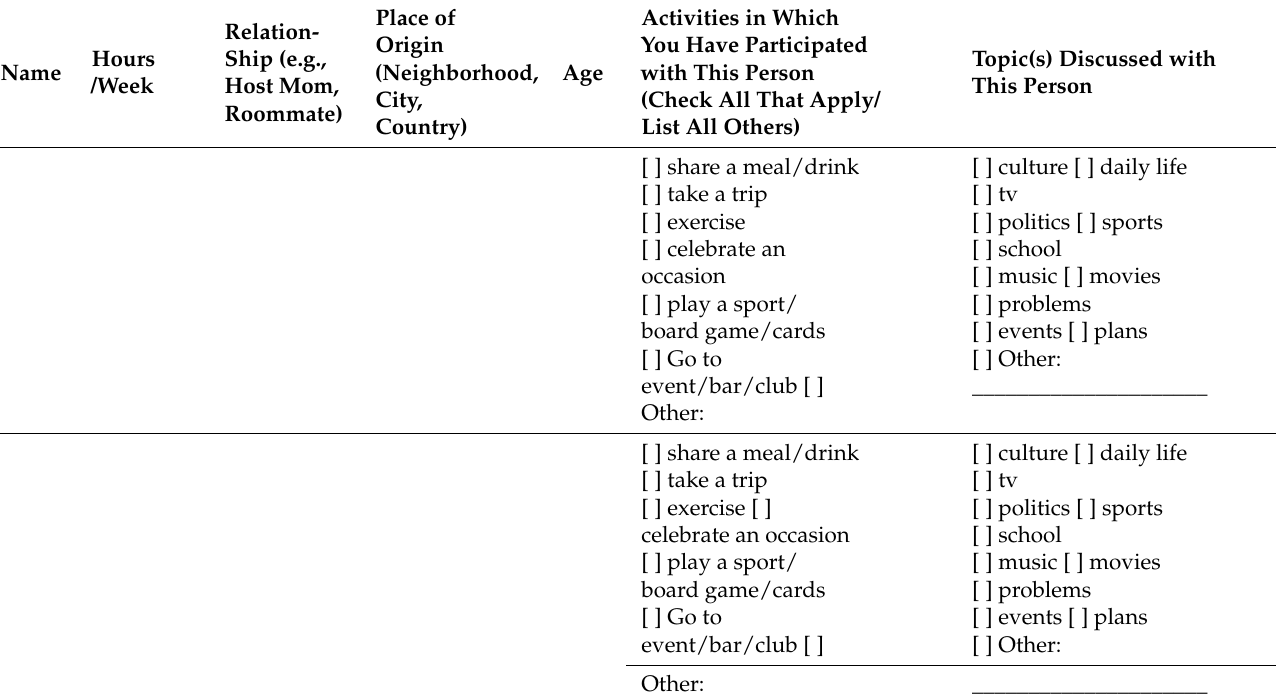
Table A1. Social Network Strength